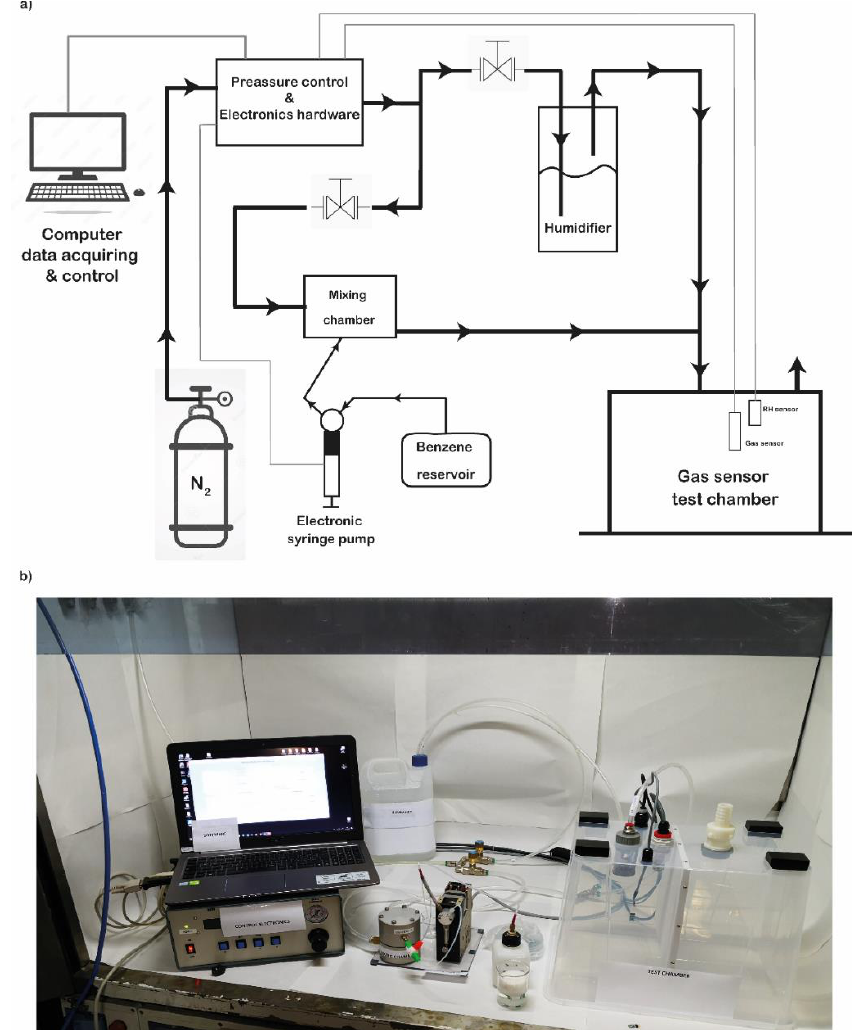
Figure 4. Gas test chamber. Schematic representation of the test chamber ( a ); real picture of the realized and used test chamber ( b